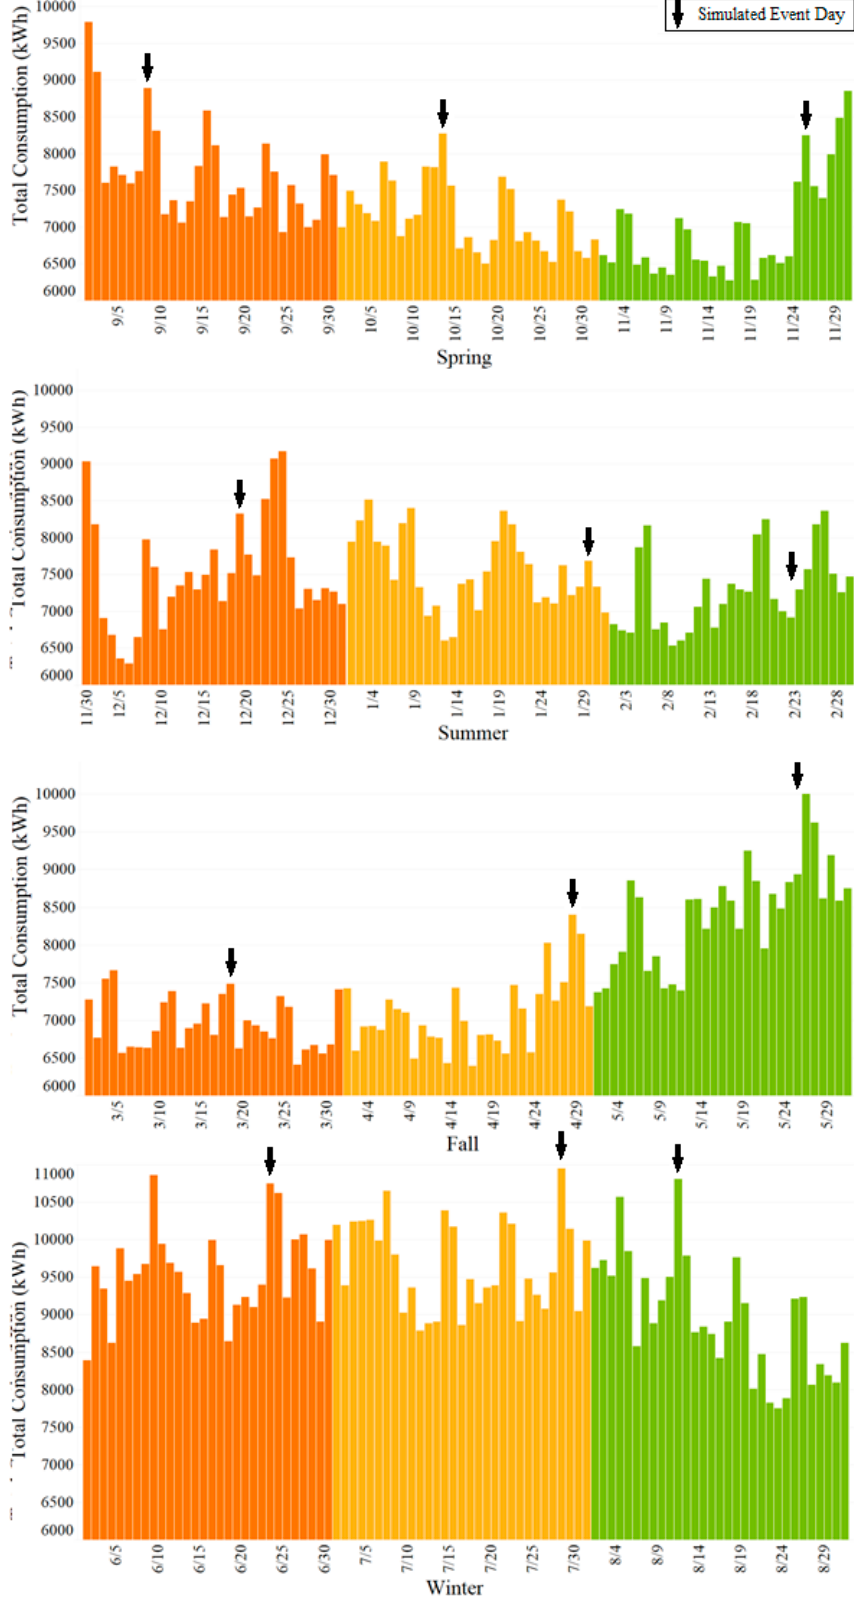
Figure 4. Total daily consumption dataset for Australian Energy Market (AEMO) for 189 residential customers, 2012.